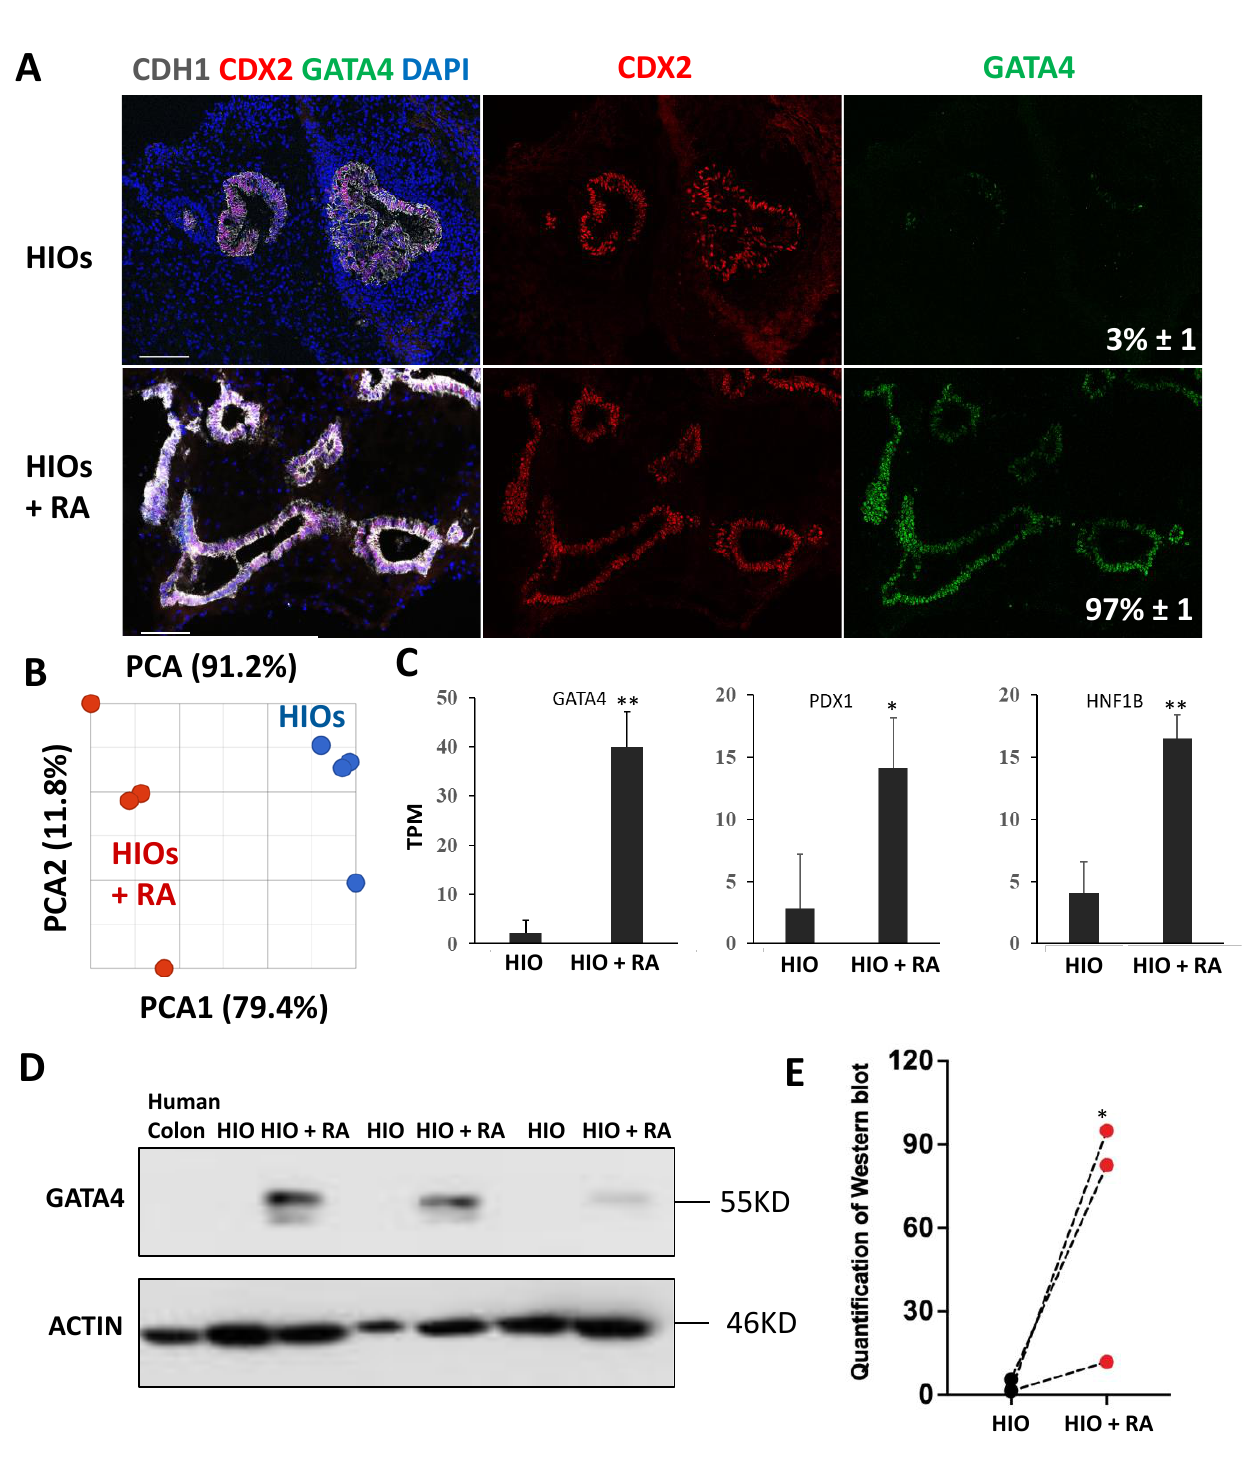
Figure 3. Retinoic acid patterns of HIOs in vitro. ( A ) Immunofluorescence staining of 35-day- old organoids from (HIOs and HIOs + RA) for CDH1 (white), CDX2 (red), GATA4 (green) and counterstained with DAPI. Numbers in GATA4 panel represent the percentage of GATA4-positive epithelial cells ± the SEM. N = 7 organoids per treatment group. ( B ) Principal of 35-day-old HIOs and HIOs + RA. N = 4 per treatment group. ( C ) Graph of TPM values from RNA-seq data of 35-day-old HIOs and HIOA. Values are displayed as the mean ± SD. n = 4 per treatment group. ( D ) Western blot for GATA4 expression from human colon (negative control), HIOs and HIOA from 3 different experiments. ( E ) Densitometric analysis of Western blot data from the panel ( C ). * denotes a p value of <0.05. ** denotes a p value of <0.01 based on t